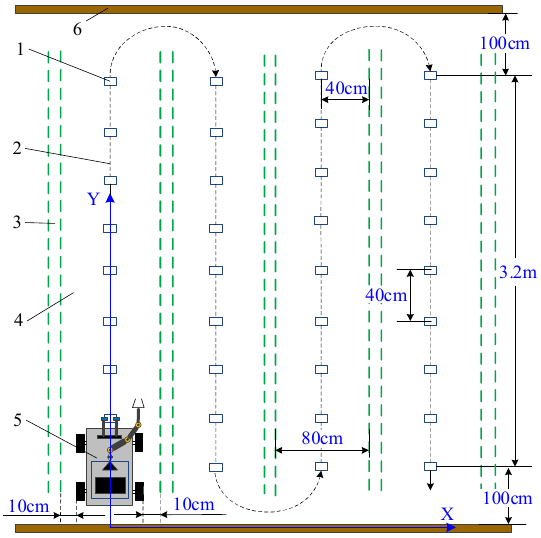
Figure 4. Schematic diagram of the intermittent mobile operation of the robotic pick. 1: chassis op- eration docking point; 2: chassis cruise path; 3: tomato plant planting line; 4: the picking robot’s traveling ridge; 5: tomato-picking robot; 6: arch bracket.